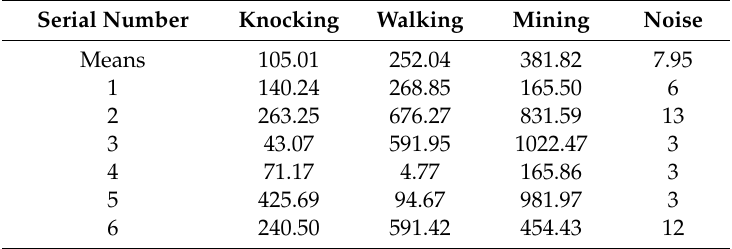
Table 2. AMNBP values of the four types of events after adaptive adjustment.